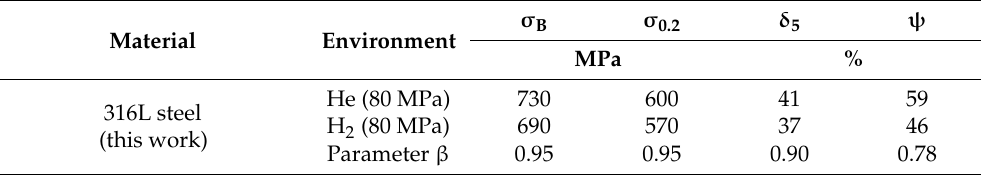
Table 3. Tensile tests results for SLM 316L steel in hydrogen and in